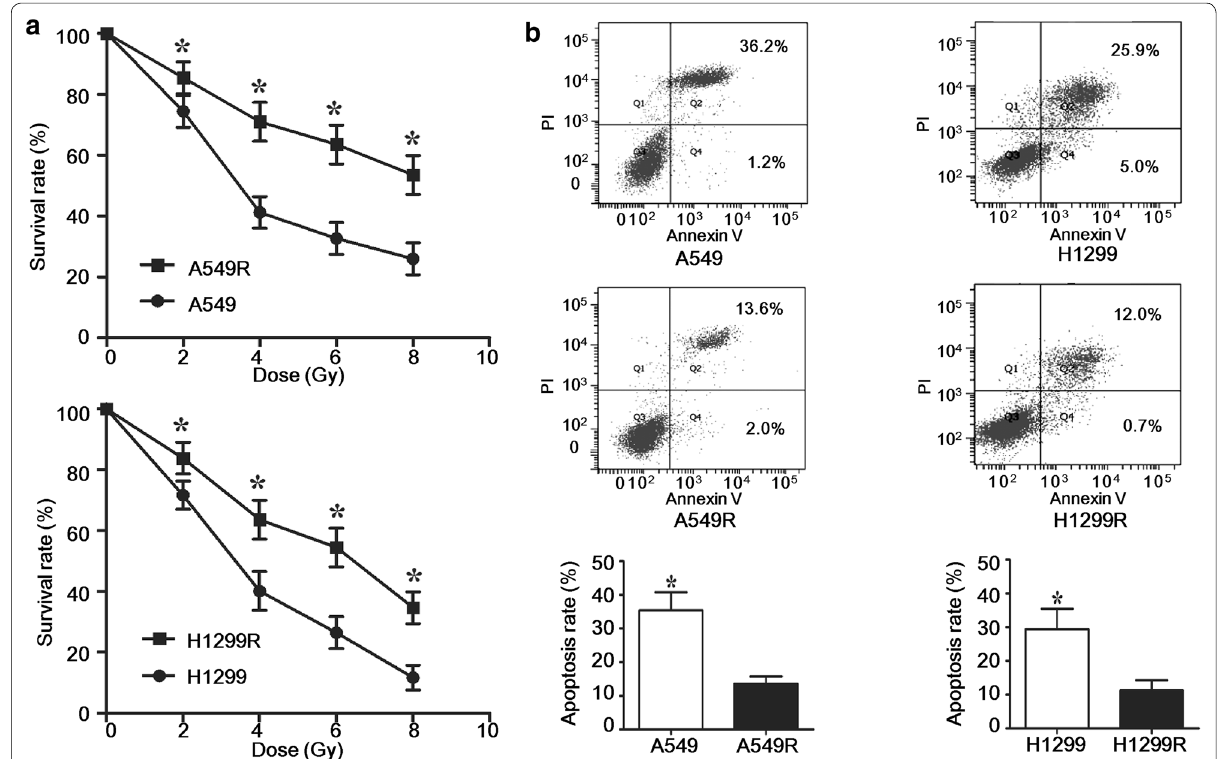
Fig. 1 A549R and H1299R cells were more resistant to ionizing radiation than the parental A549 and H1299 cells. a The cells were irradiated with the indicated dose; 48 h later, Cell Counting Kit‑8 assay was performed to detect the viability and proliferation of the cells. The survival rate was nor‑ malized to the non‑irradiated controls. * P < 0.05 (Student’s t test). b The cells were irradiated with 2 Gy of X‑ray; 24 h later, the apoptosis of the cells was determined by Annexin V‑FITC/propidium iodide (PI) staining and fluorescence‑activated cell sorting analysis. Representative results are shown. The apoptotic fraction (Q2 Q4) from three independent experiments was used to plot the bar chart . * P < 0.05 (Student’s t +